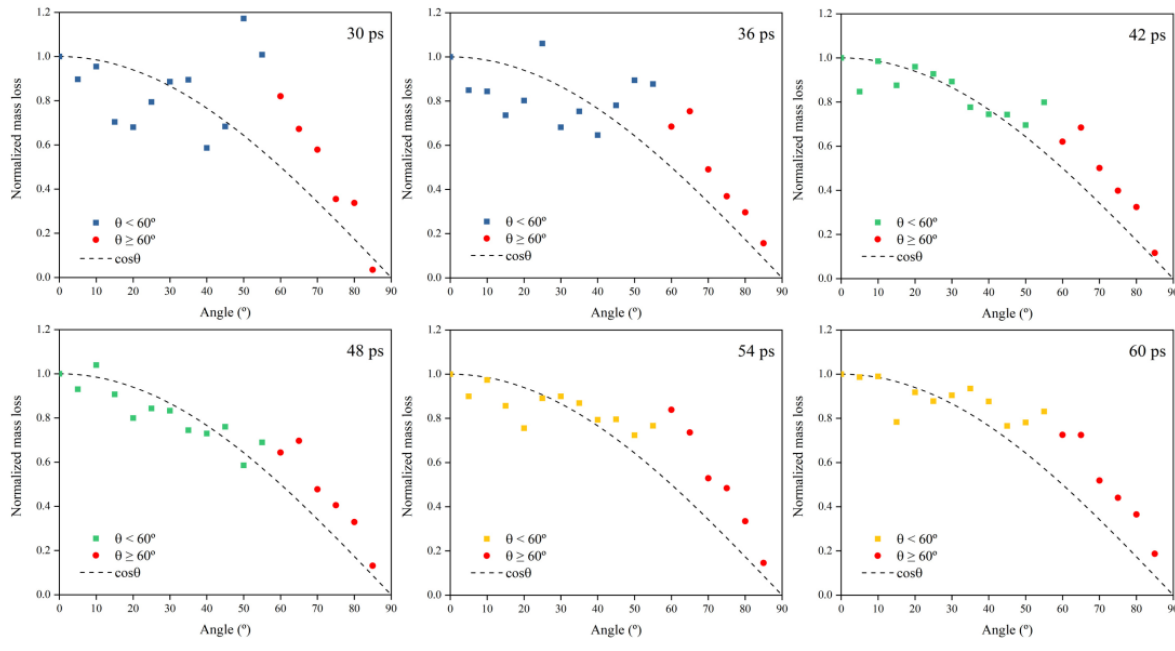
Figure 9. Normalized mass loss of the Kapton during atomic oxygen impact at different incidence angles.